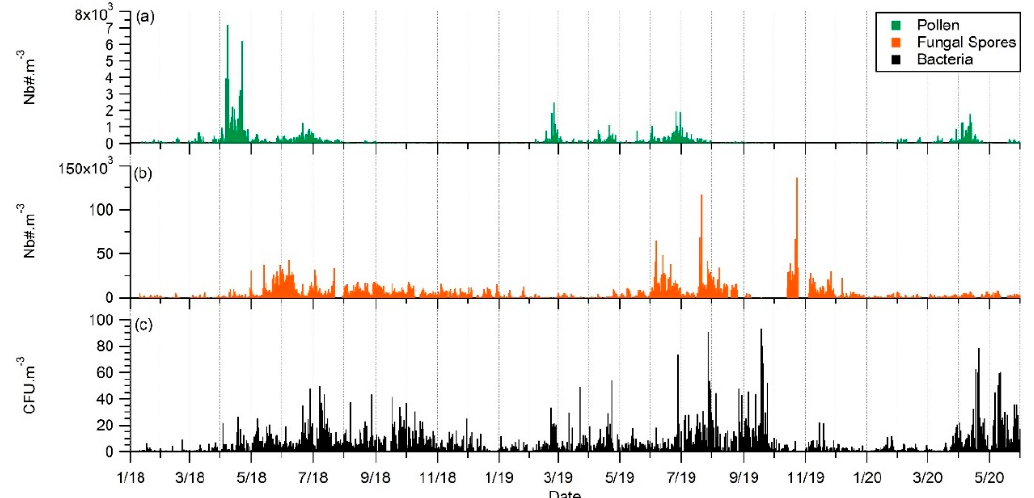
Figure 9. Variability of the three major airborne bioaerosols: Pollen grains ( a ), Fungal Spores ( b ), and cultivable Bacteria ( c ) measured at Saclay observatory from (01 January 2018 to 31 May 2020).